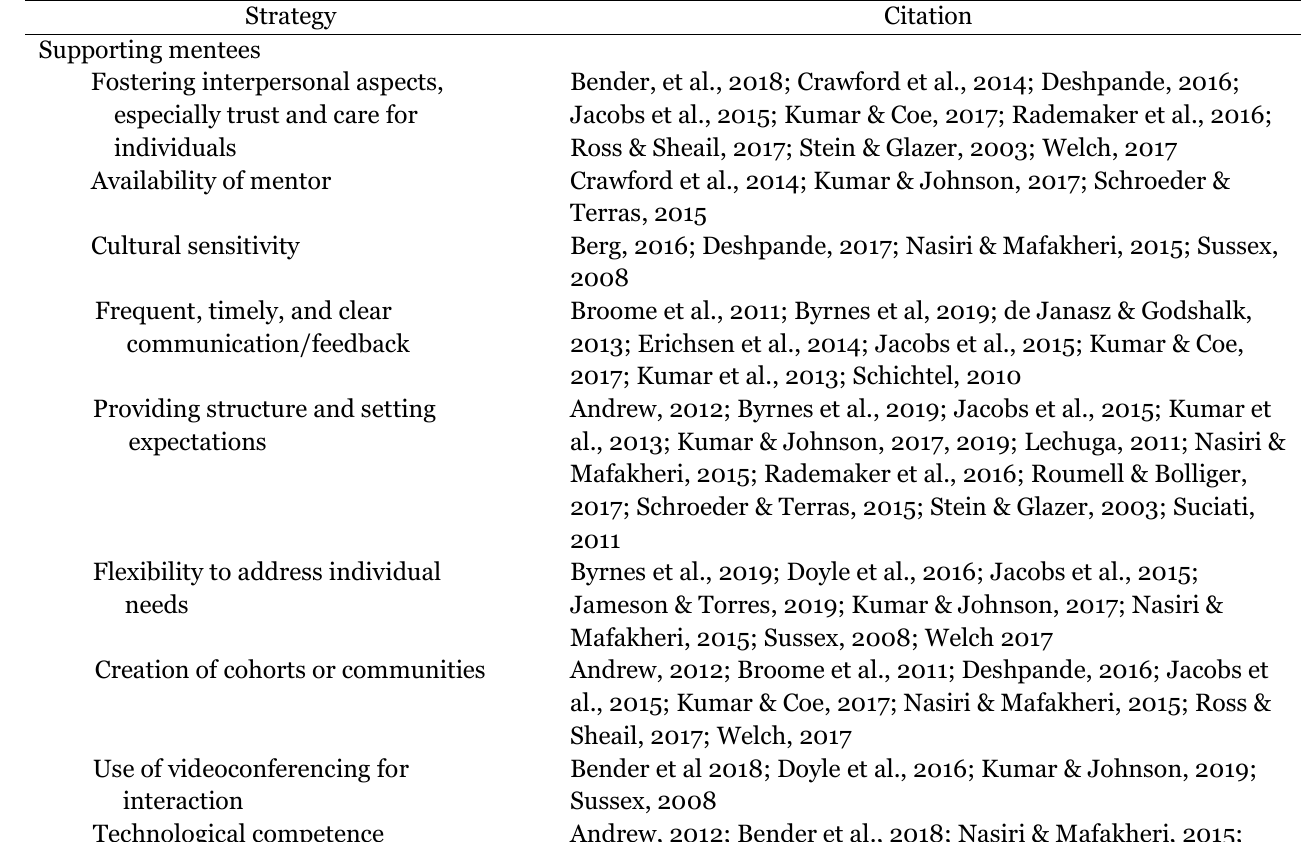
Strategies for Graduate Mentoring Online